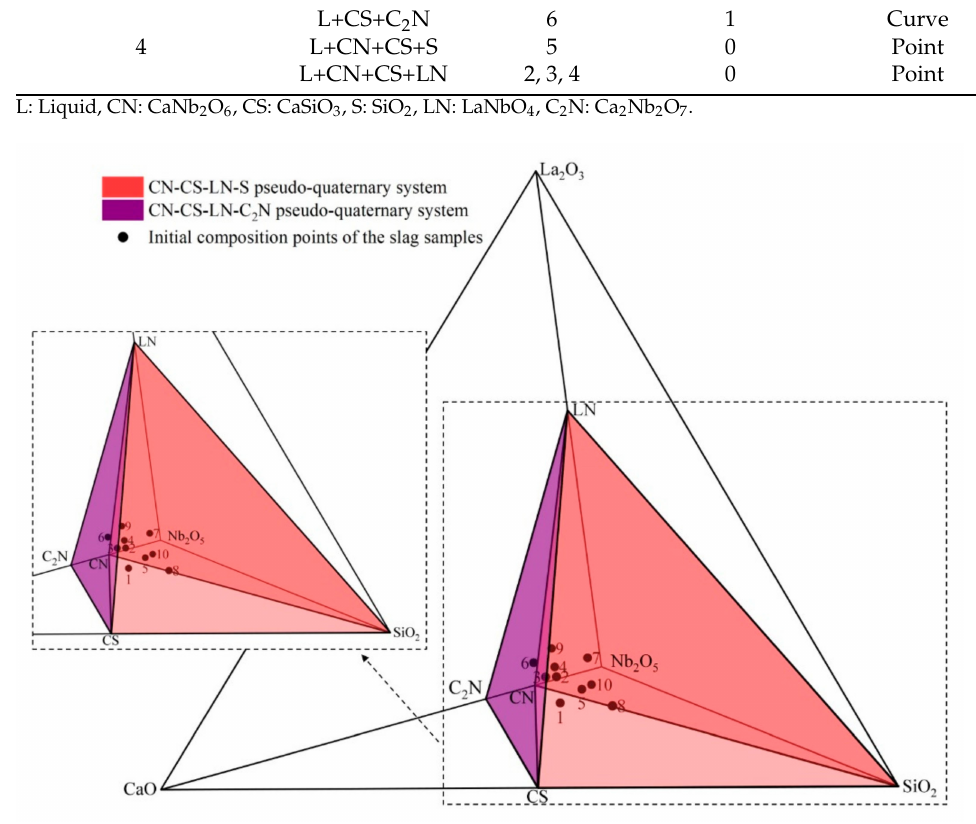
Figure 3. Phase equilibria of CaO-SiO 2 -La 2 O 3 -Nb 2 O 5